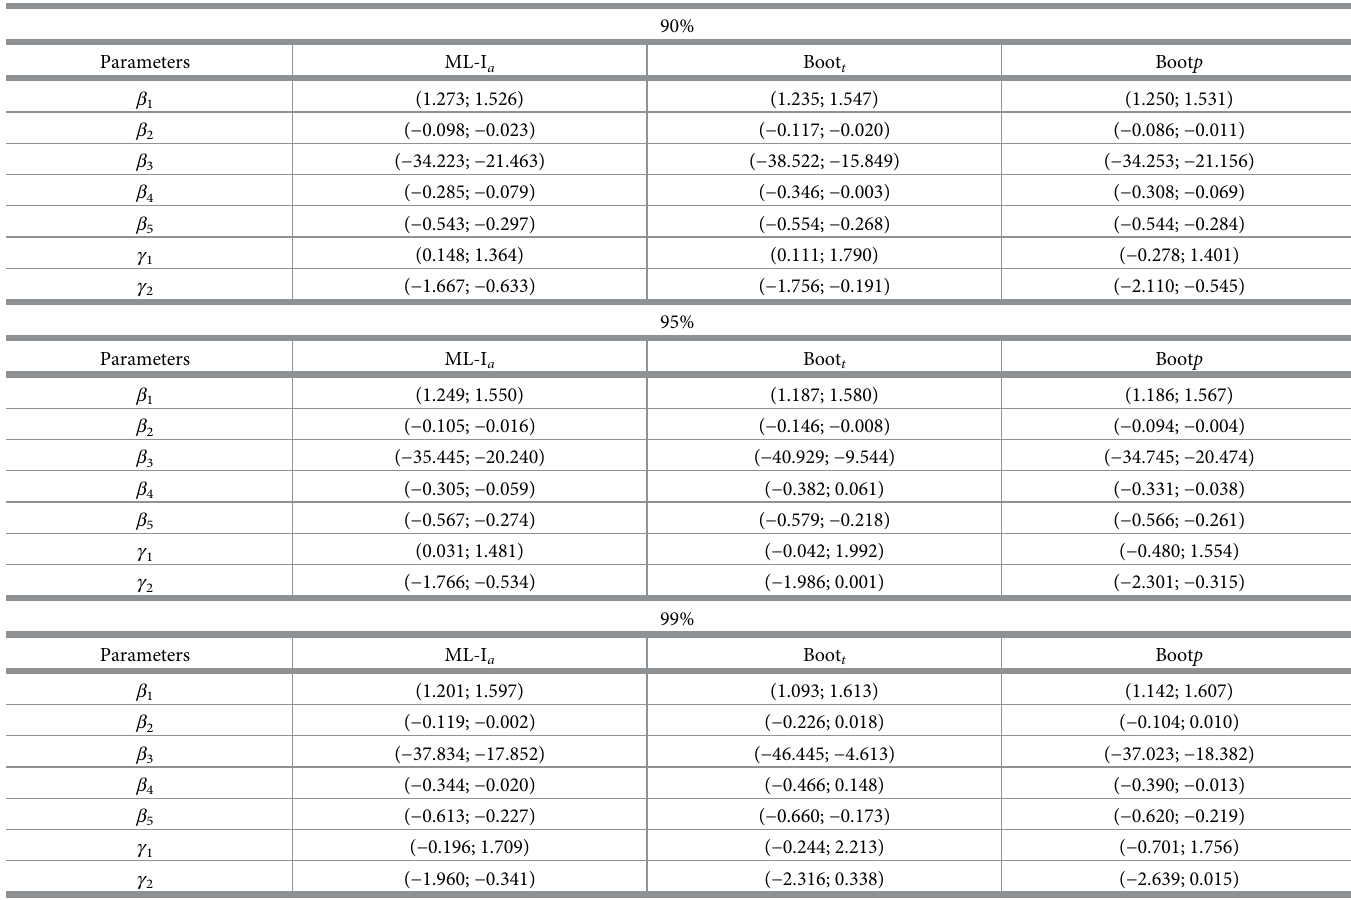
, Boot and Boot p interval estimates for the parameters of the Model ‘Model-I’. Fluid catalytic cracking (FCC) data. a t